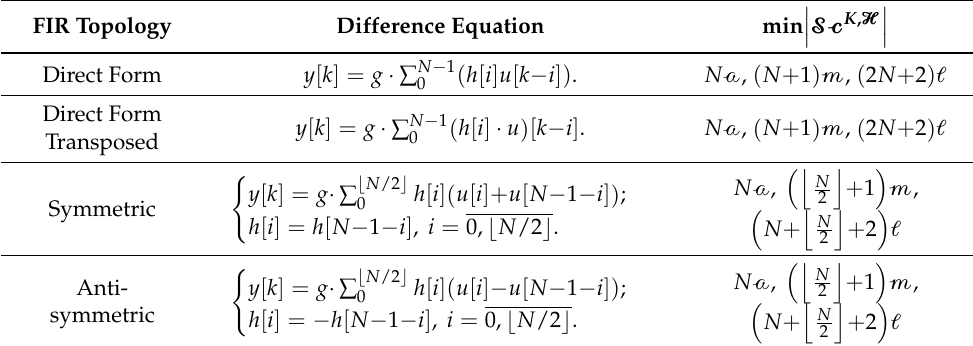
Table 4. Digital FIR filter topology implementations; all difference equations implement the same input-output N th order transfer function, but vary through the configuration of the accumulator.